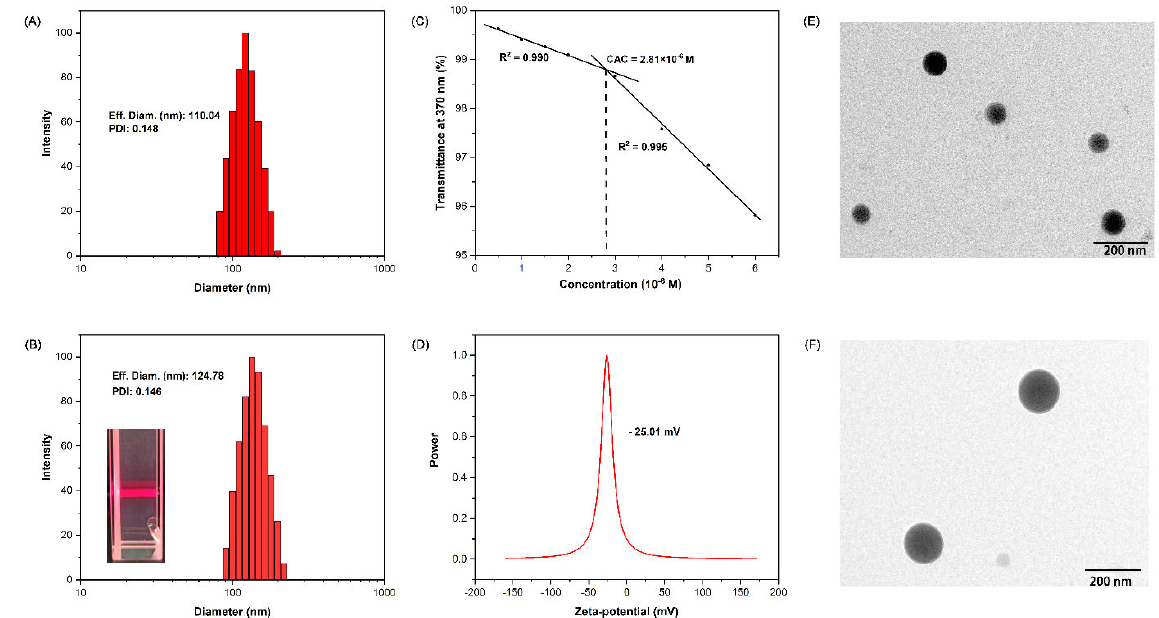
Figure 1. DLS data of ( A ) BNPs and ( B ) GOx@BNPs, inset: Tyndall effect of GOx@BNPs; ( C ) CAC determined by the concentration-dependent optical transmittance of BNPs at 370 nm; ( D ) ζ -potential of GOx@BNPs; TEM images of ( E ) BNPs and ( F ) GOx@BNPs.